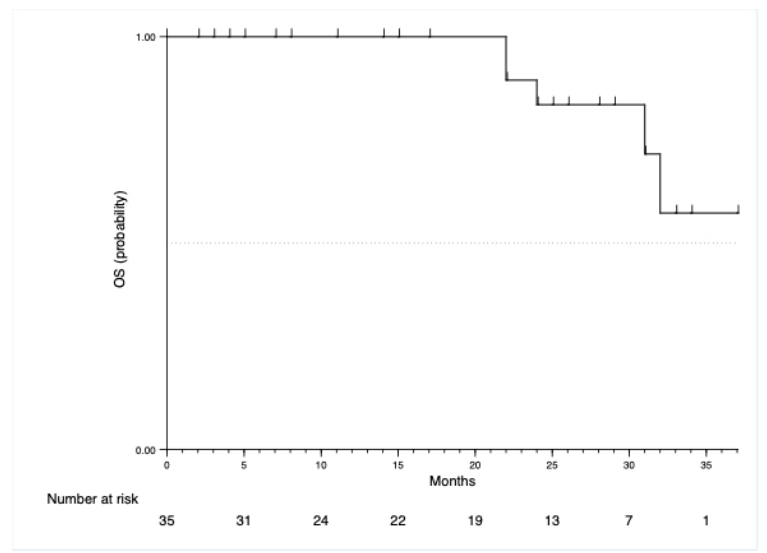
Figure 3. Kaplan-Meier estimates of progression-free survival (PFS) based on investigator assessment. The median overall survival in the group of patients ≥ 65 years old was 32